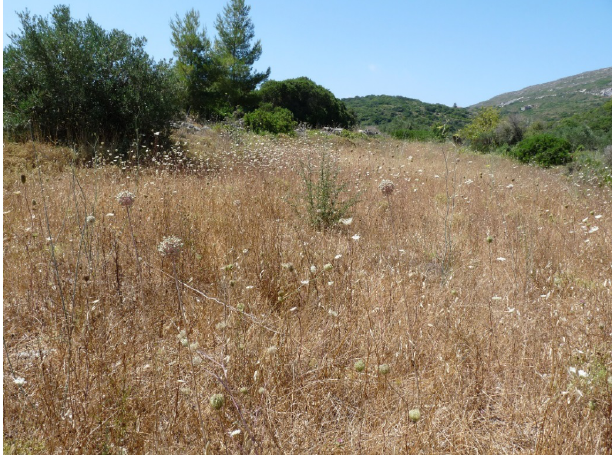
Figure 2. Allium ampeloprasum L. (TK072; Mylopotamos, Kythera) in its natural